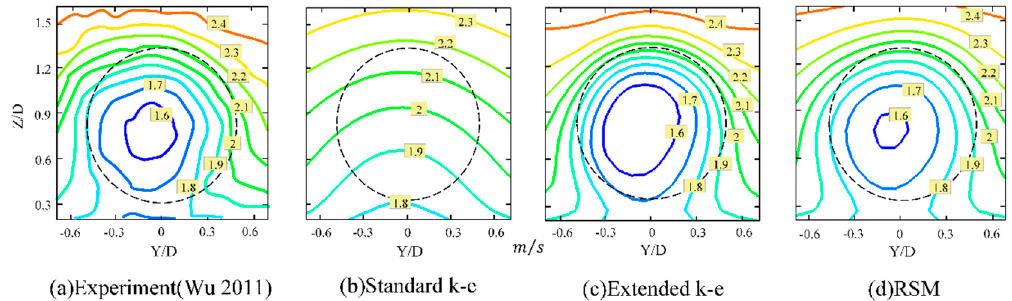
Figure 8. Contours of stream ‐ wise velocity at 5 D downstream, ( a ) experiment data (obtained from